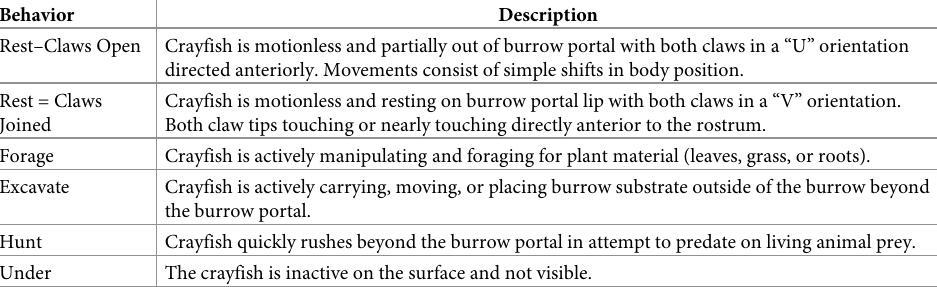
Table 2. Ethogram used to quantify the behaviors from recordings of Lacunicambarus thomai . Behavior